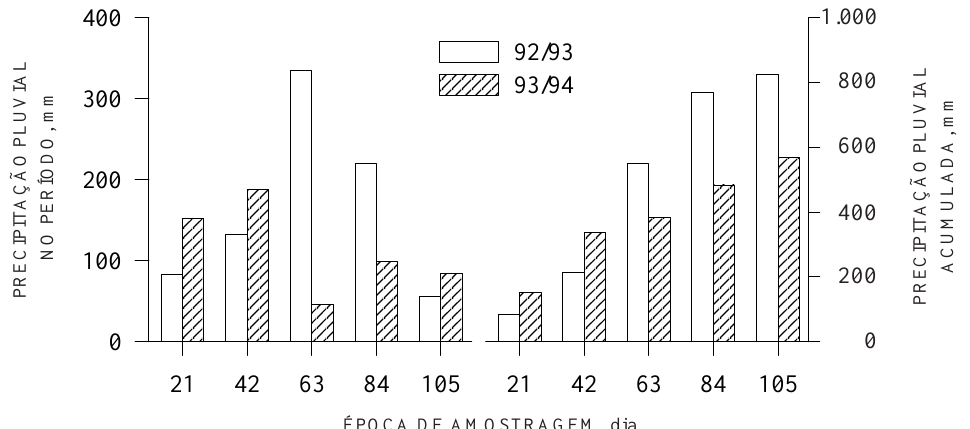
Figura 2. Precipitação pluvial nas proximidades da área experimental durante o período de amostragem nos anos agrícolas de 1992/93 e